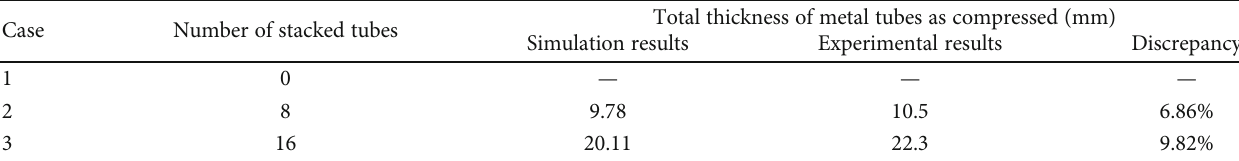
Table 7: Thickness of metal tubes under